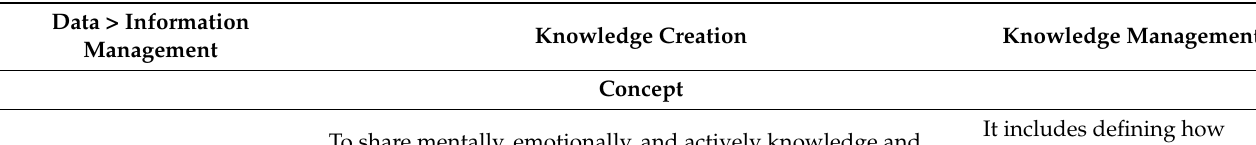
Table 1. From information management to knowledge